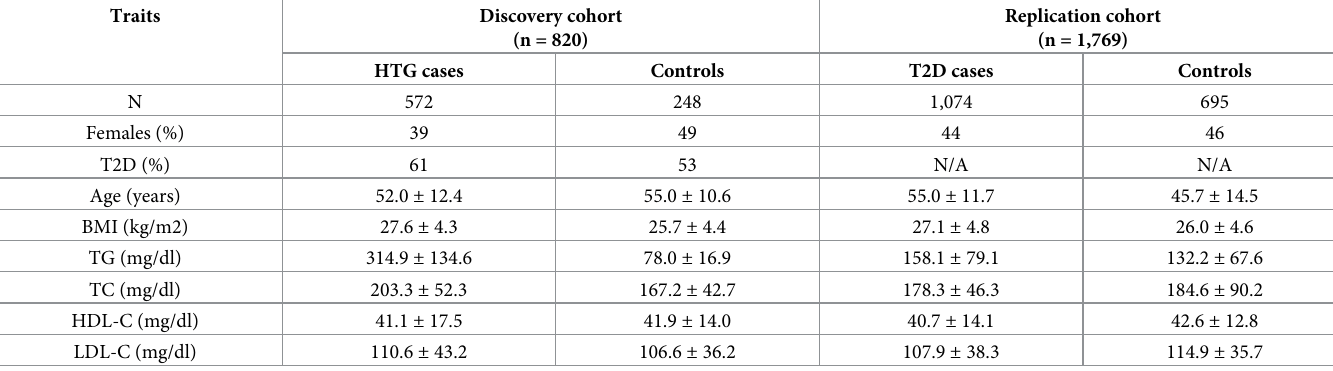
Table 1. Phenotypic attributes of discovery (sequencing) and replication cohorts as part of Asian Indian Diabetic Heart Study (AIDHS).